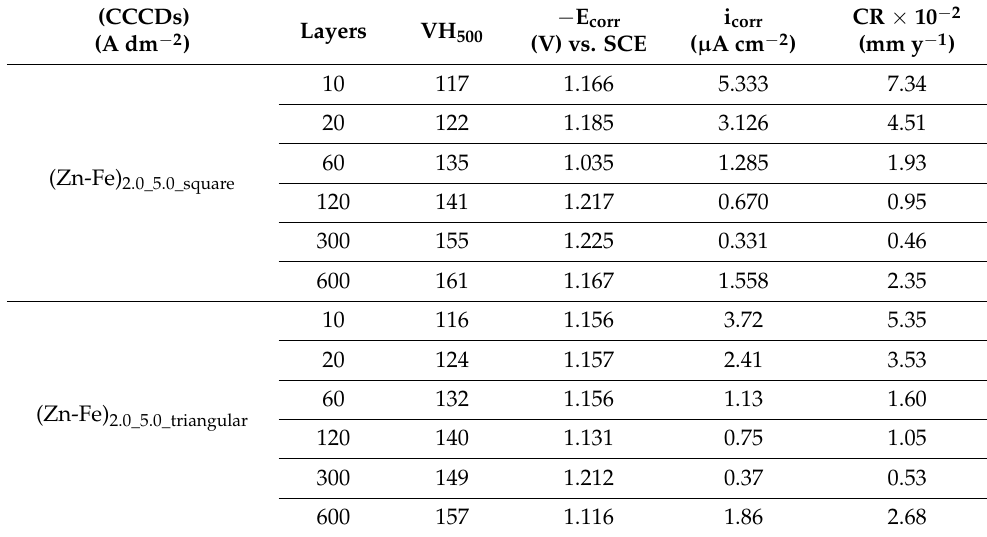
Table 4. Corrosion properties of multilayer coatings with square and triangular current